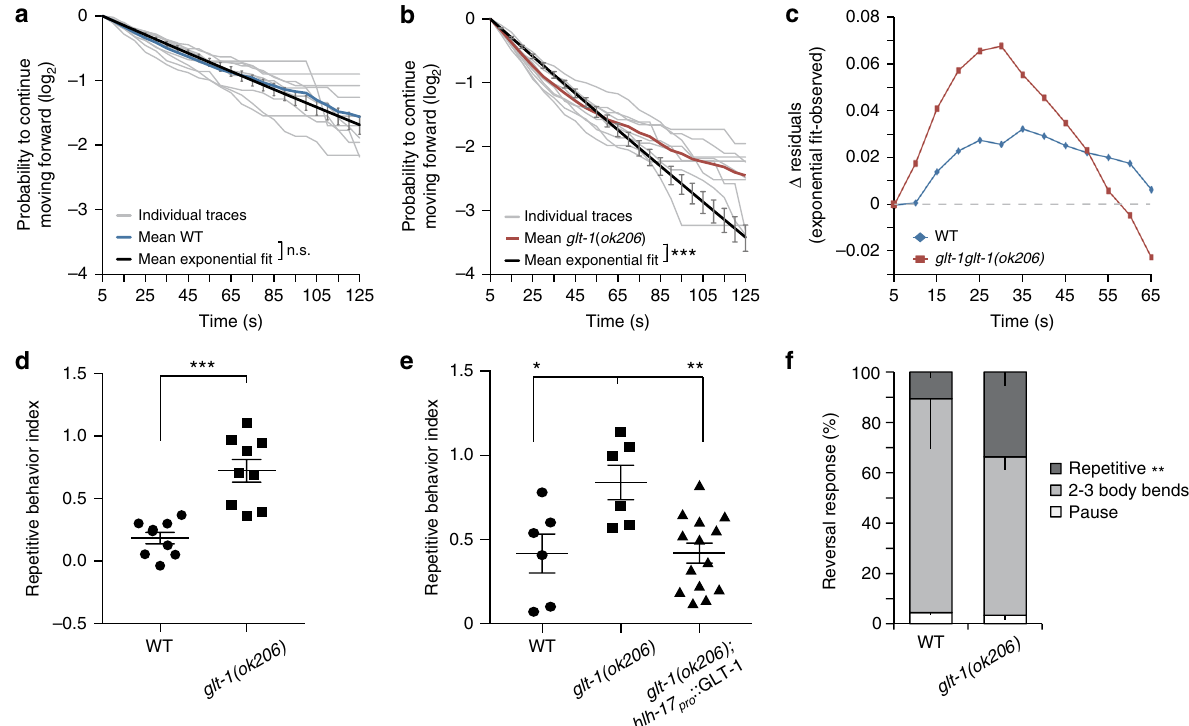
Fig. 3 GLT-1 prevents repetitive reversal behavior. a Probability that following a reversal, a wild-type animal will move forward for the time indicated on the horizontal axis. Exponential fi ts are plotted in black ± SEM, light gray lines are probability distributions of individual movies (blue, mean plot; n = 9 movies). b Same as ( a ), except in glt-1 mutants (red, mean plot; n = 9 movies). a , b χ 2 -test used to determine if exponential fi t differs from mean observed data (colored lines; n.s., nonsigni fi cant; *** p < 10 − 15 ). c The residual difference between the mean exponential fi t and the mean observed reversal probability for wild-type (WT; blue) and glt-1 (red) mutants at the indicated time intervals. d glt-1 mutants exhibit repetitive reversal behavior (from data in ( a ) (circles), ( b ) (boxes), Student ’ s t test, *** p < 0.0005). e GLT-1 in CEPsh glia rescues repetitive reversals (ANOVA Tukey ’ s HSD post hoc test, * p < 0.05, ** p < 0.005; WT (circles) n = 6, glt-1(ok206) (boxes) n = 6, glt-1(ok206) ; hlh-17 pro ::GLT-1 (triangles) n = 14 movies). f glt-1 mutants respond to mechanical stimuli with repetitive reversals (Student ’ s t test, ** p < 0.005; WT n = 16, glt-1(ok206) n = 13 animals). d – f Bars, mean ± SEM. Source data are provided as a